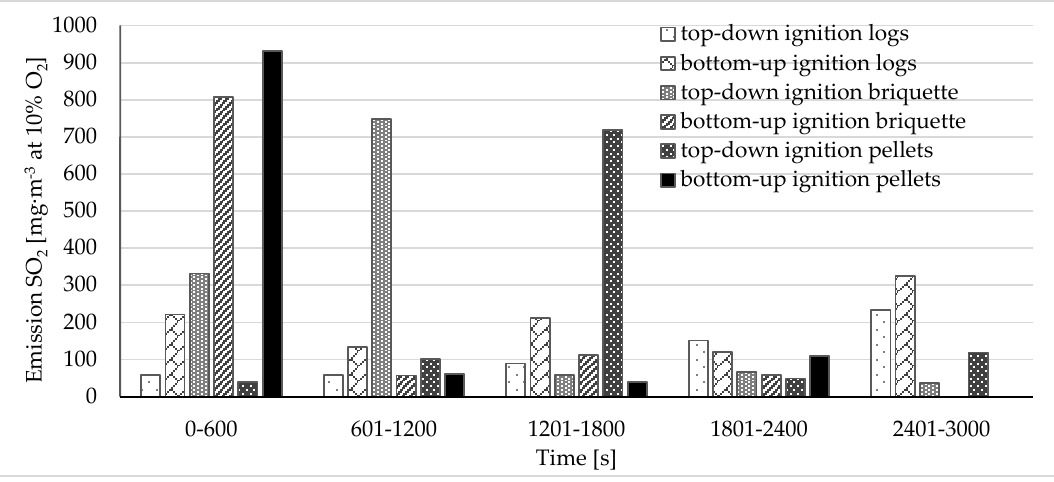
Figure 5. Changes in sulfur dioxide emission during the combustion of the selected biomass forms (average values for separate combustion phases and ignition techniques).